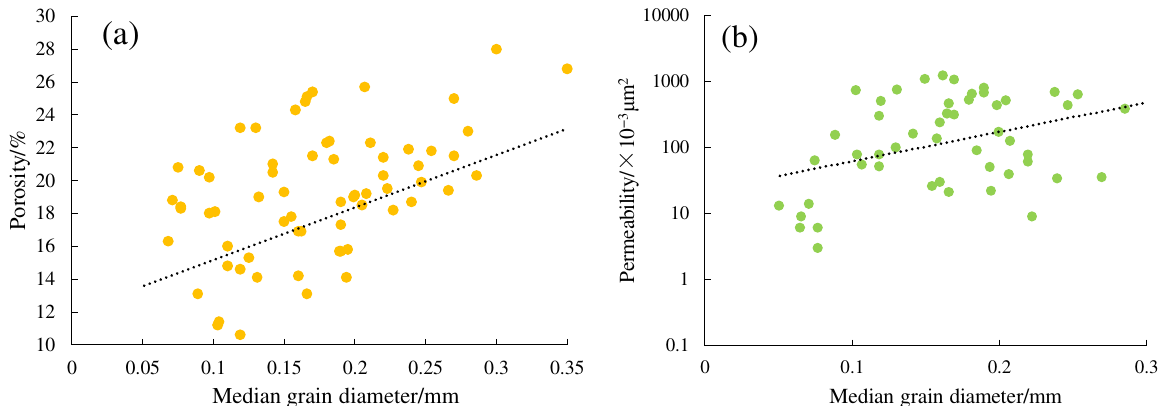
Figure 10. Relationship between particle size and physical properties of Z Ⅱ 3 in the Wang Guantun area. ( a ) porosity and median grain diameter; ( b ) permeability and median grain diameter.